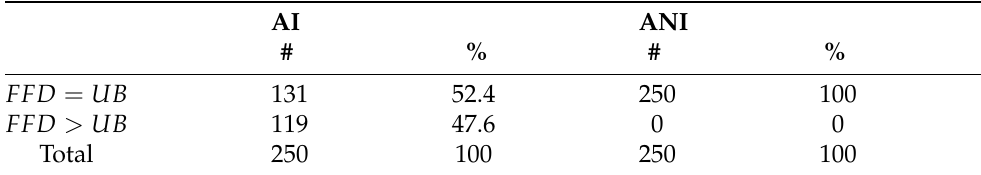
Table 1. Comparison with FFD for the AI and ANI